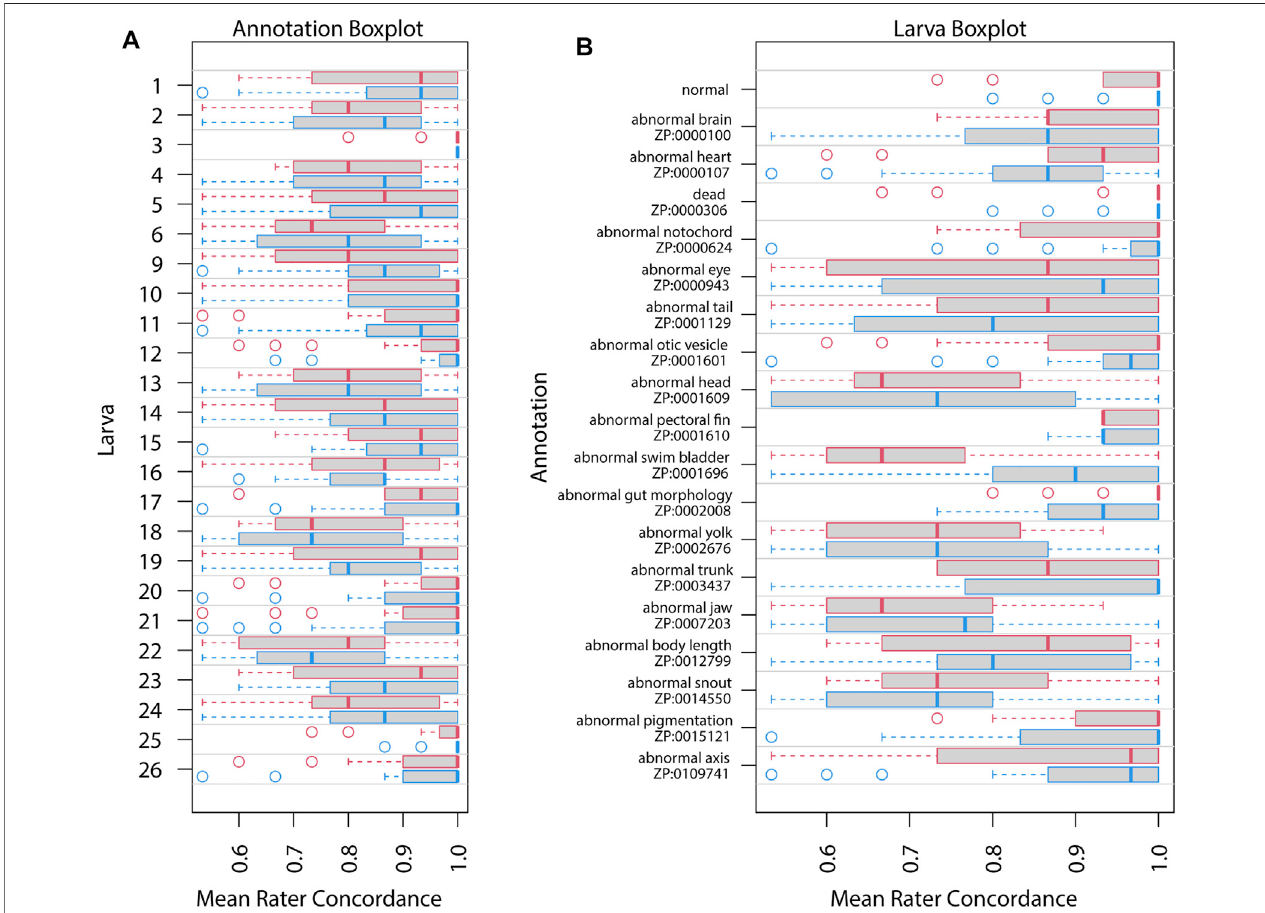
FIGURE3| Meanraterconcordanceusinggeneralphenotypeterms.Theseboxplotsshowthemeanconcordance( x axisandredorbluebarinshadedbox)ofthe raters by larva (A) or by annotation (B) with interquartile range indicated by shaded area ( fi rst to third quantiles). Data from Survey 1 are in red and from Survey 2 are in blue.Thedashedwhiskersdenotethedatathatarewithin1.5timestheinterquartilerange,withcirclesannotatingdataoutsidethatrange.Pleasenotethatlarvae7and8 did not exist. No data were discarded.